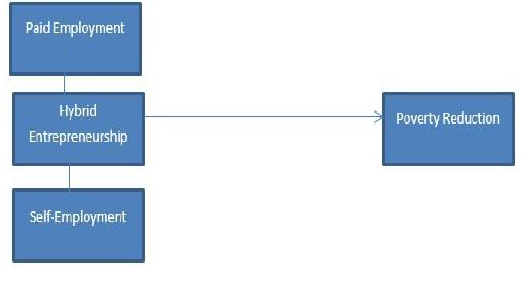
Figure 1. Conceptual Framework of Research Source: Researchers’ Conceptual Framework, 2021